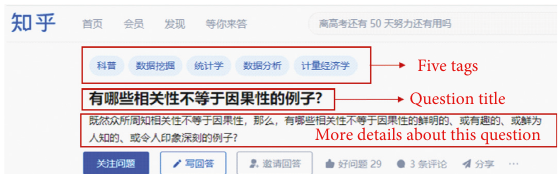
Figure 1: An example of the relationship of question and